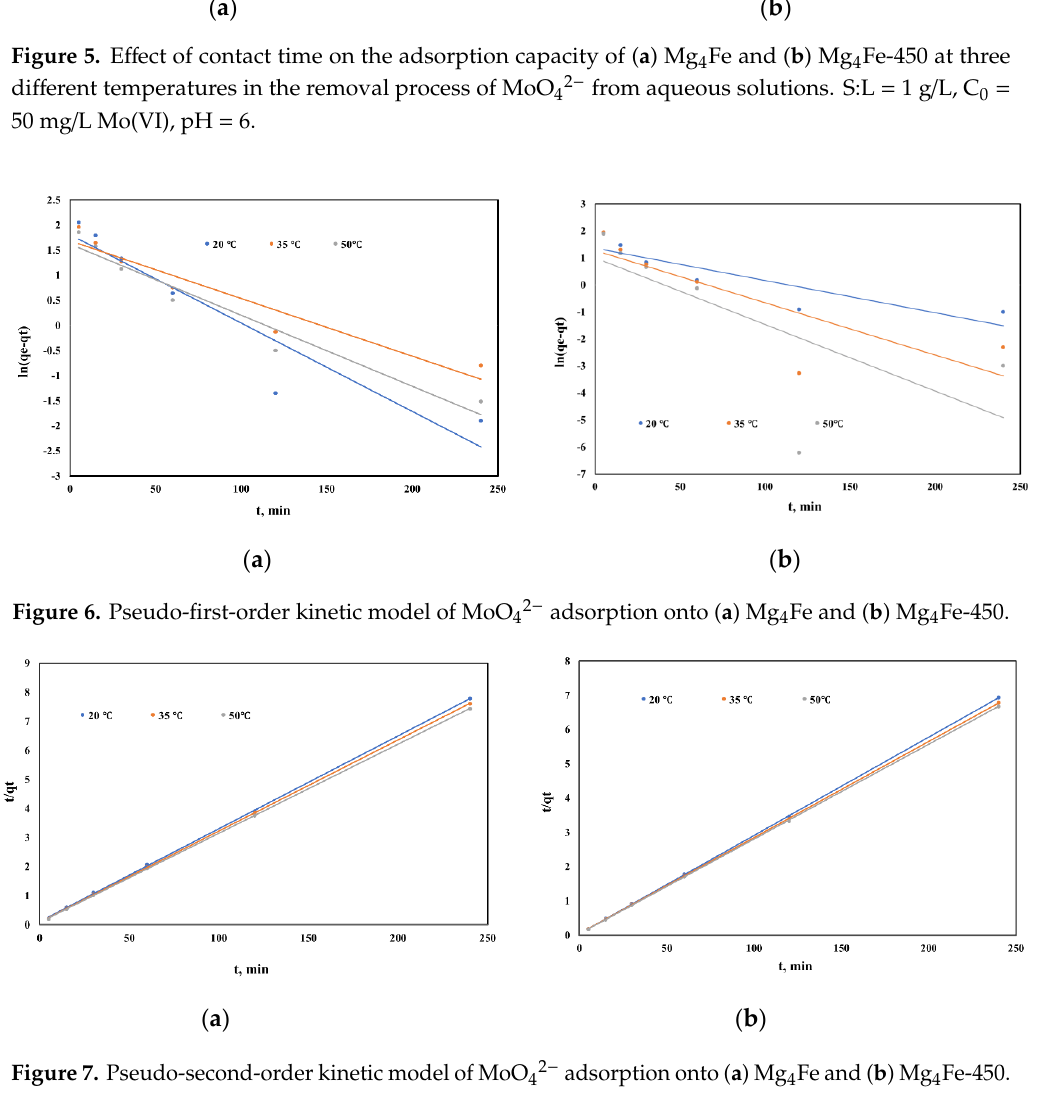
4 Fe and ( b ) Mg 4